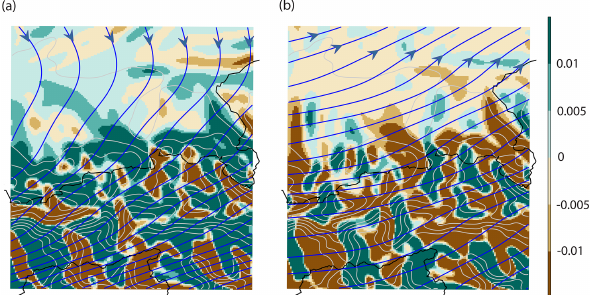
Figure 3. Illustration of G w , the wind-aligned gradient, for two classes of the PCACA9 circulation-type classification: (a) north- easterly flow in summer, and (b) southwesterly flow in fall. The example fields are valid for a smoothing scale of 5km. The topog- raphy is depicted in grey lines (spacing 250m) and the streamlines of the geostrophic wind are shown by the blue